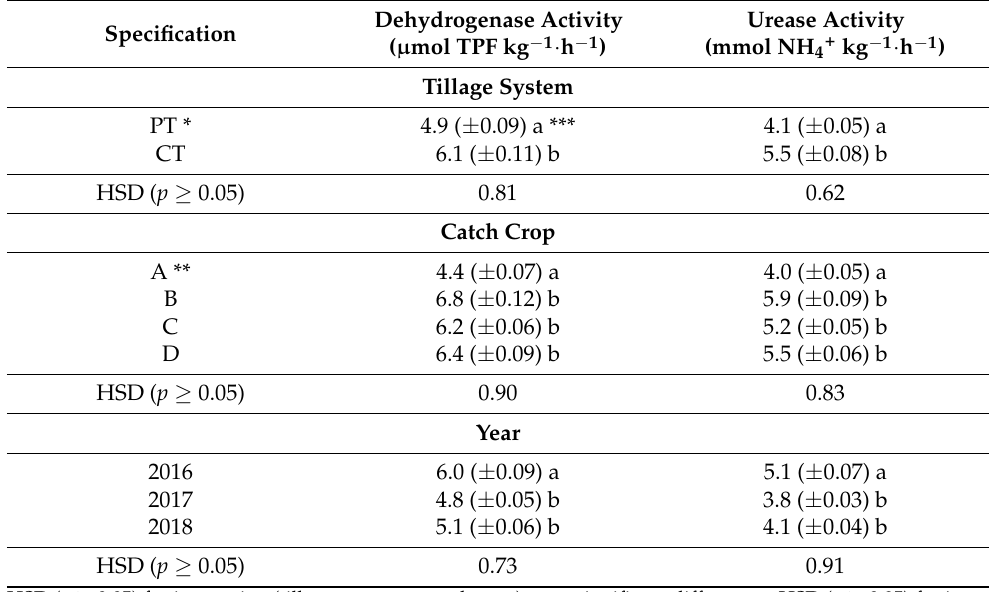
Table 7. Soil enzymatic activity in 0–20 cm layer.